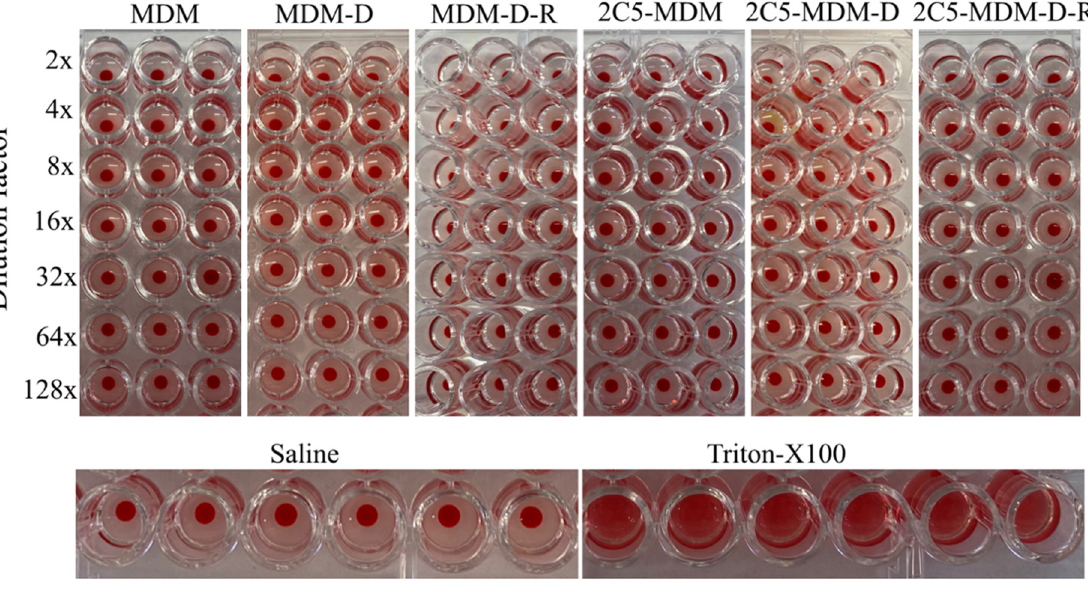
Figure 2. Hemolysis data depicting the safety of the micelles prepared. The stock nanoparticles in this experiment had 1.8 mg/mL of PAMAM . this experiment had 1.8 mg/mL of